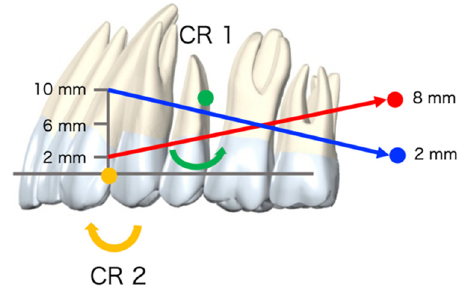
Figure 12. Supposed two centers of rotation; each CR functions in the opposite direction. CR1: the center of rotation of dentition, which is assumed to be positioned at the cervical half or third of the distal root surface of the second premolars; CR2: the center of rotation of the junction of the main arch and hook.